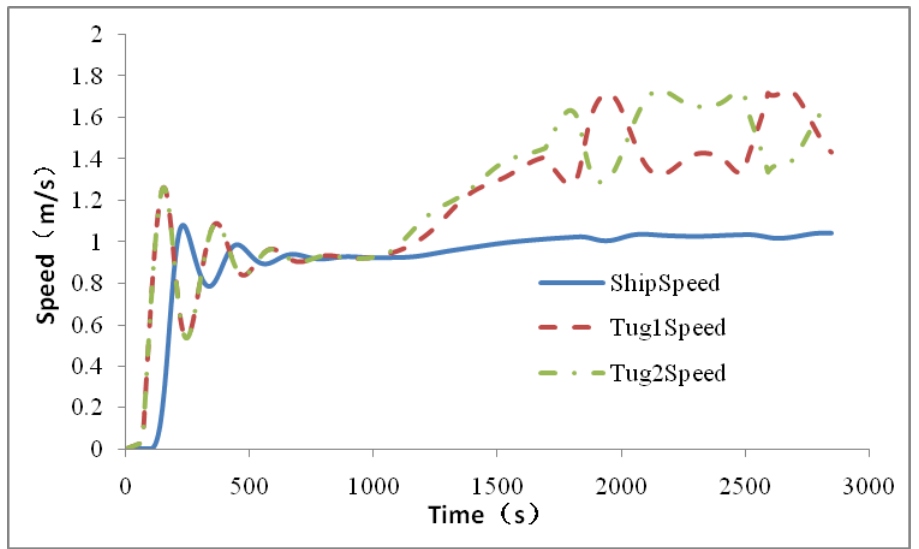
Figure 9. Speed analysis diagram of towage under rotary condition of towage system.